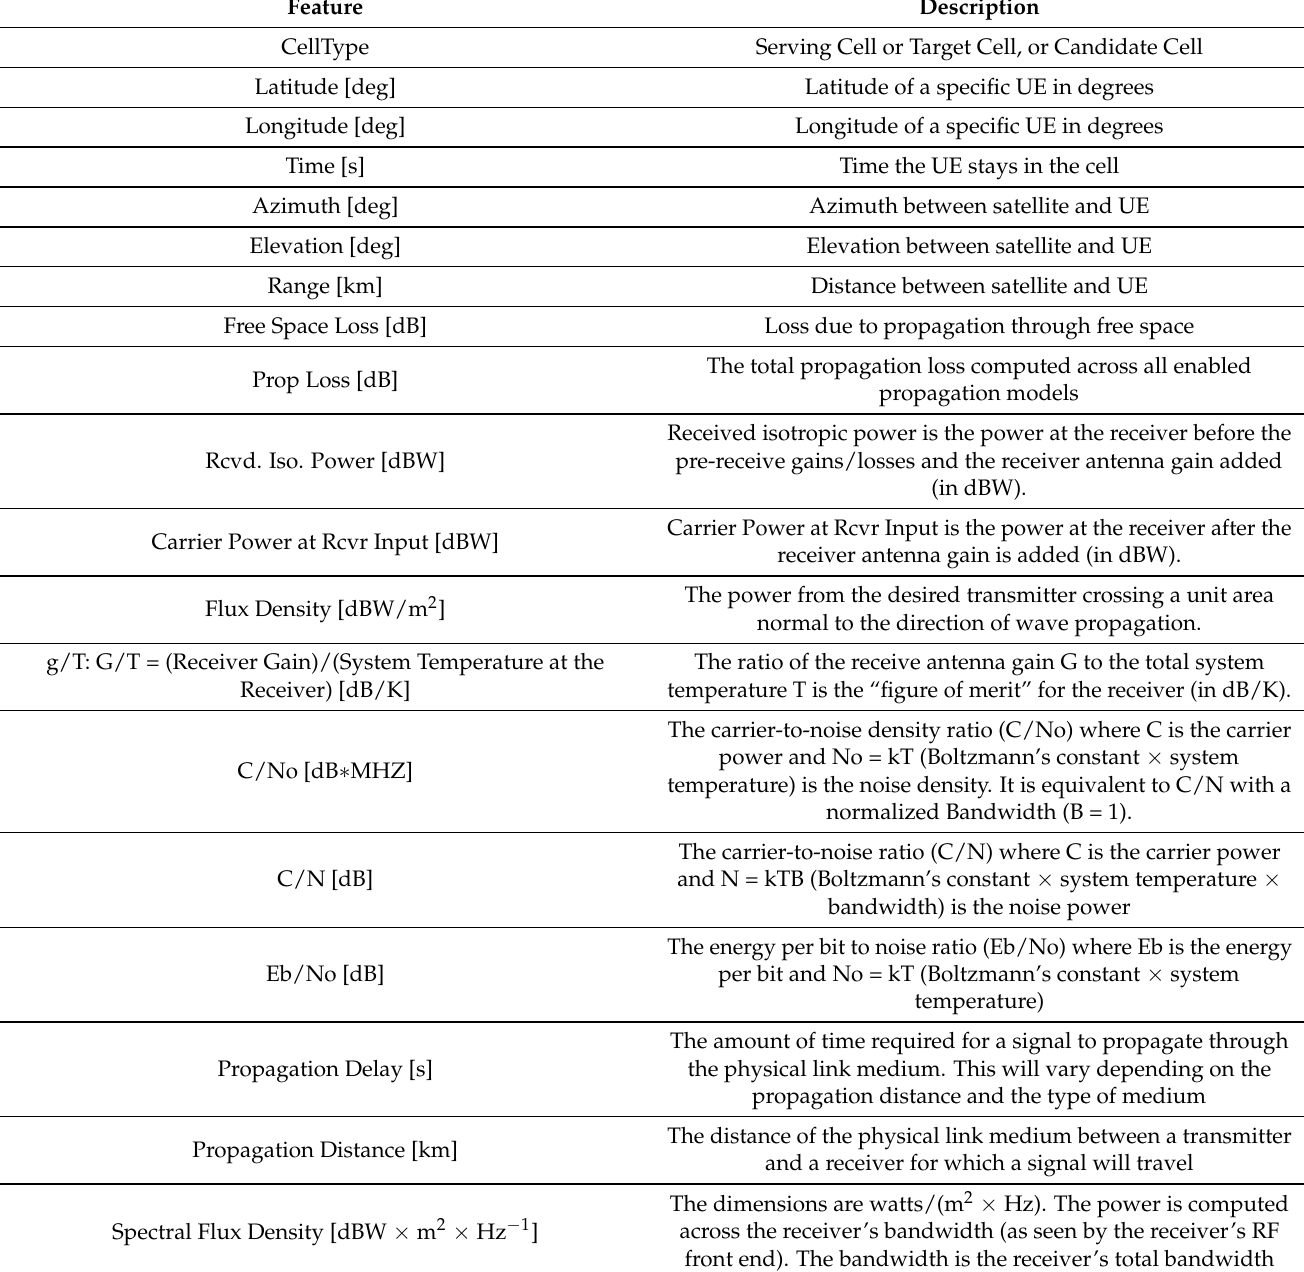
Table 1. User Equipment